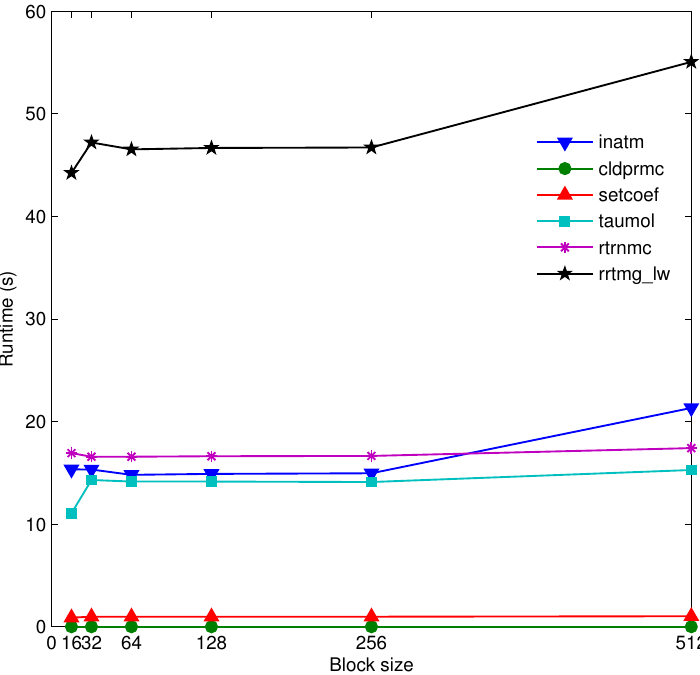
Figure 6. Run-time of the 1-D G-RRTMG_LW on one K40 GPU.